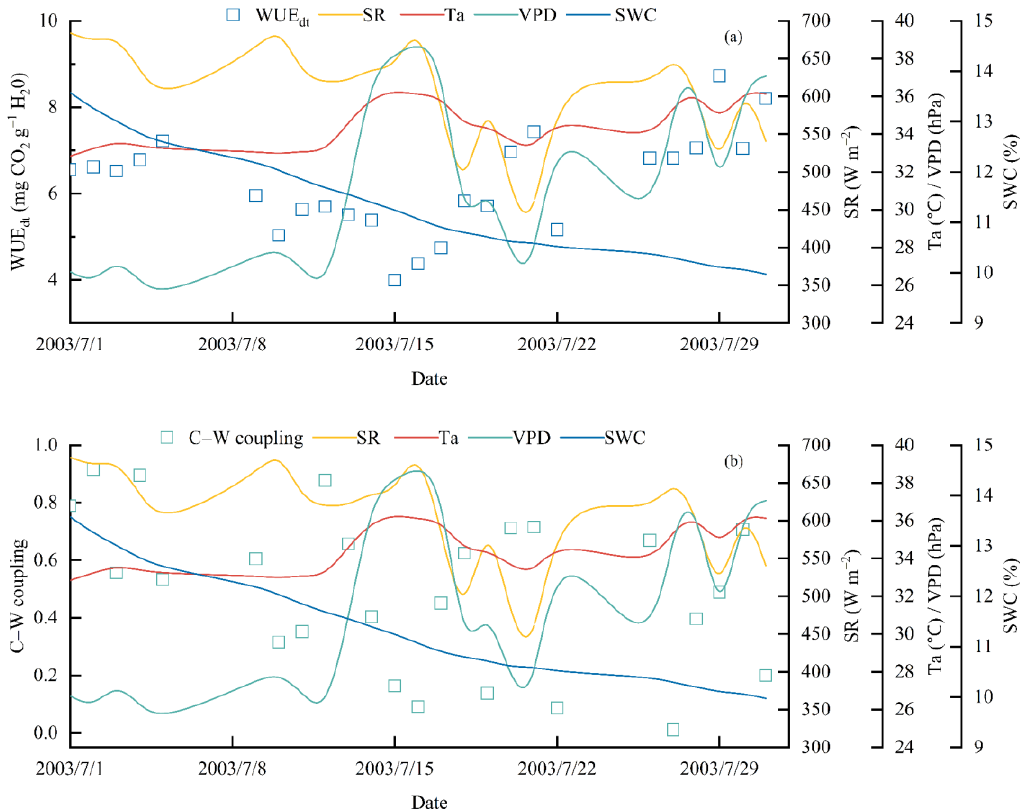
Figure 2. An example of daily variations in daytime water use efficiency (WUE dt , ( a ), blue hollow squares) and diurnal carbon – water coupling (C – W coupling, ( b ), cyan hollow squares) in July 2003 at Qianyanzhou, along with meteorological conditions. The solid lines in yellow, red, cyan, and blue indicate the daily means of shortwave radiation (SR), air temperature (T a ), vapor pressure deficit (VPD), and soil water content (SWC), respectively, during the daytime (6 a.m.–6 p.m.).